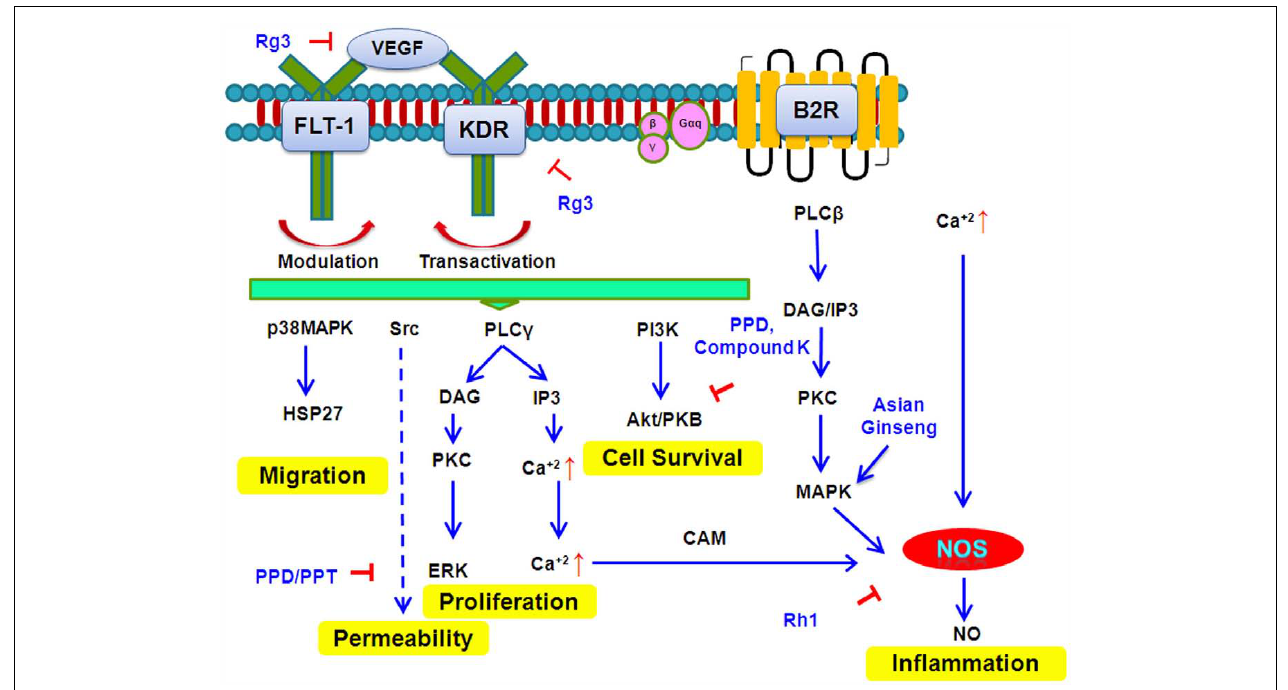
FIGURE 6 | SignalTransduction pathways targeted by selected